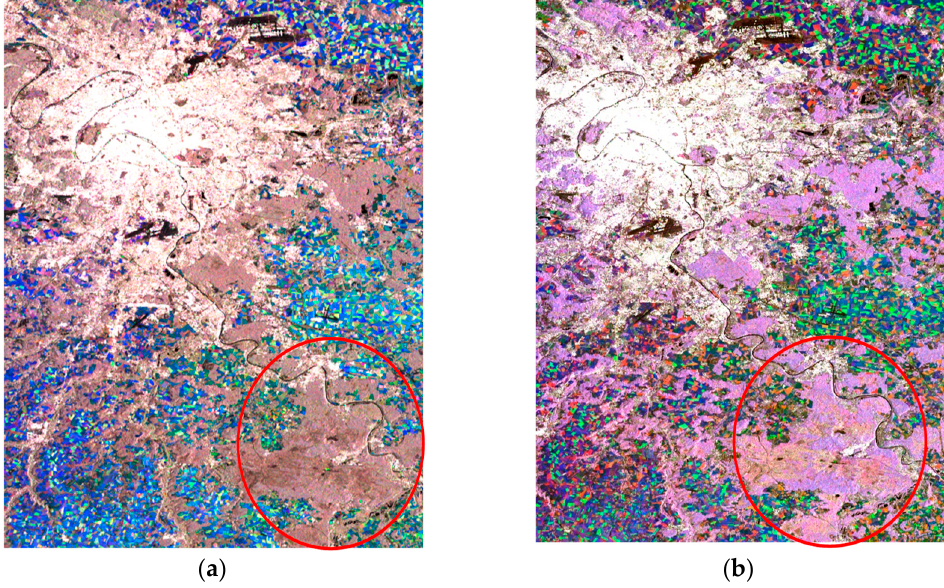
Figure 3. Temporal color-composite σ 0 image, (R: 05/05/2015, G: 02/09/2015, B: 19/12/2015) ( a ) VV polarization; ( b ) VH polarization. The area corresponds to the dashed rectangle in Figure 2. The red circle corresponds to the Fontainebleau Forest.